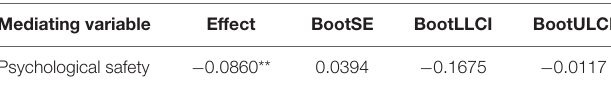
TABLE 6 | Mediation analysis.